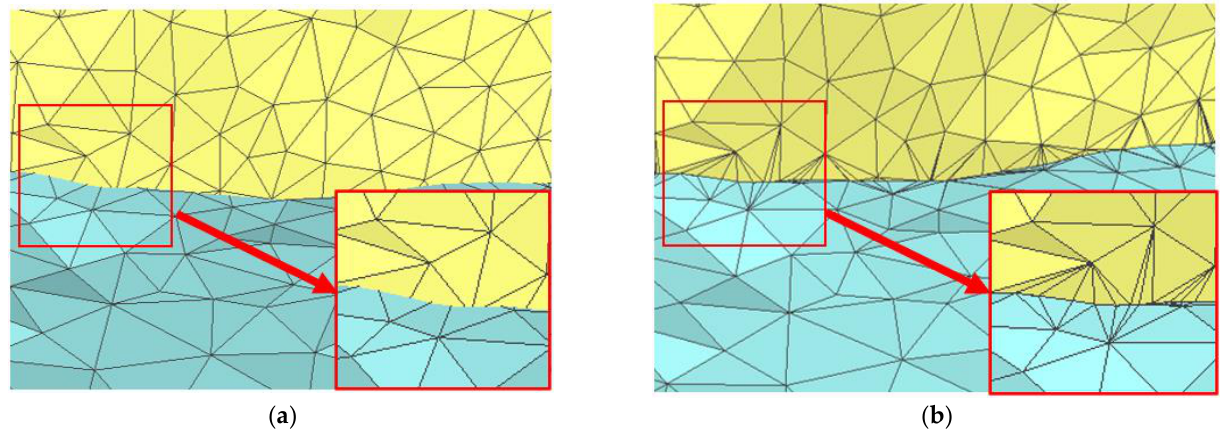
Figure 11. Example of triangulation of intersecting surface. ( a ) shows two intersecting planes. ( b ) shows two intersecting surfaces with geometrical topology